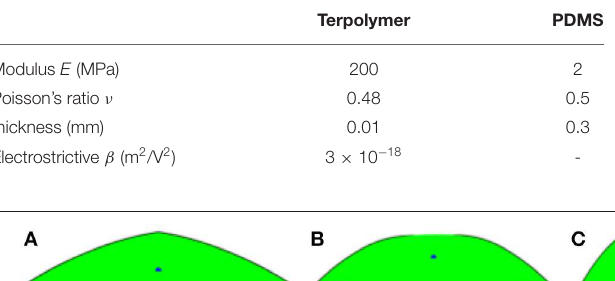
TABLE 1 | Material and geometrical properties.